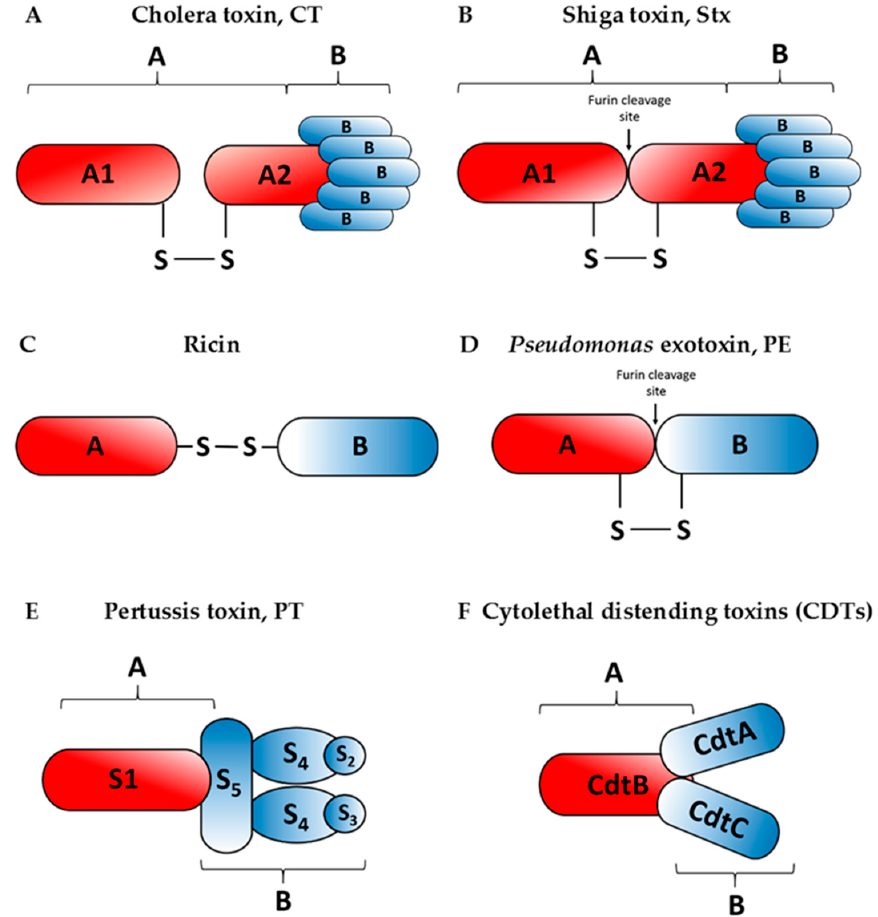
Figure 2. Schematic structures of the cholera toxin, CT ( A ), Shiga toxin, Stx ( B ), ricin ( C ), Pseudomonas exotoxin, PE ( D ), the pertussis toxin, PT ( E ) and cytolethal distending toxins, CDTs ( F ). Enzymatically active moieties are indicated as A, whereas binding moieties are indicated as B. Names of particular subunits of the A and B moieties for each toxin are marked inside the subunit structures. In case of the cholera toxin, the A subunit is cleaved before reaching the target cells which is indicated on the diagram by separation of the A subunits.